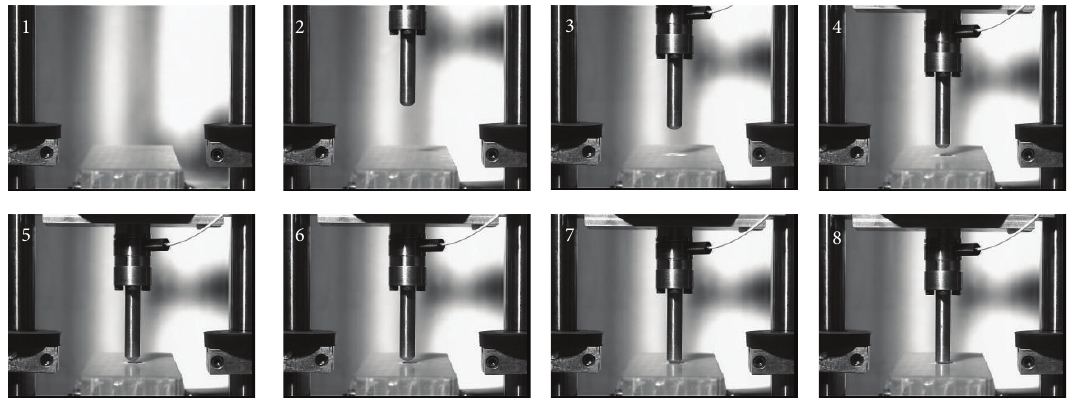
Figure 6: The impact sequences of the sandwich composites taken from the high speed video